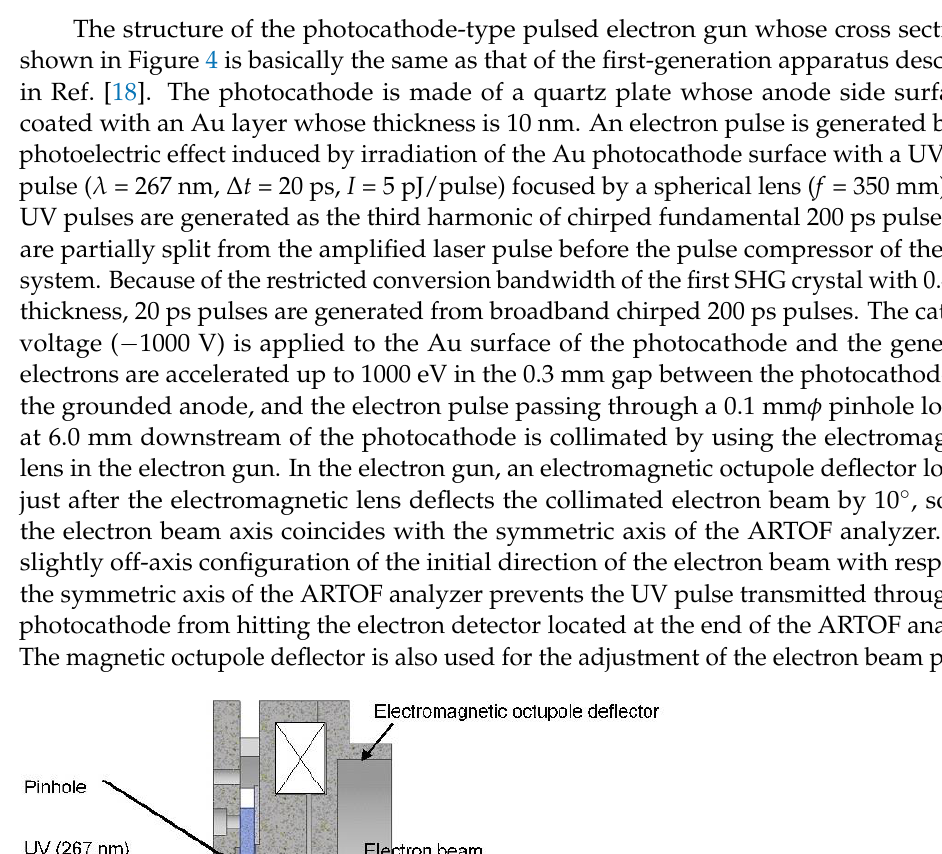
Figure 3. ( a ) An expanded view of the nozzle unit to which a thin gold wire for the adjustment of the horizontal position of the nozzle. ( b ) The normalized signal intensity of the electrons elastically scattered by Ne atoms plotted as a function of the horizontal nozzle position along the direction parallel to the laser beam. Filled circles: experimental results. Solid curve: a best-fit Gaussian function.